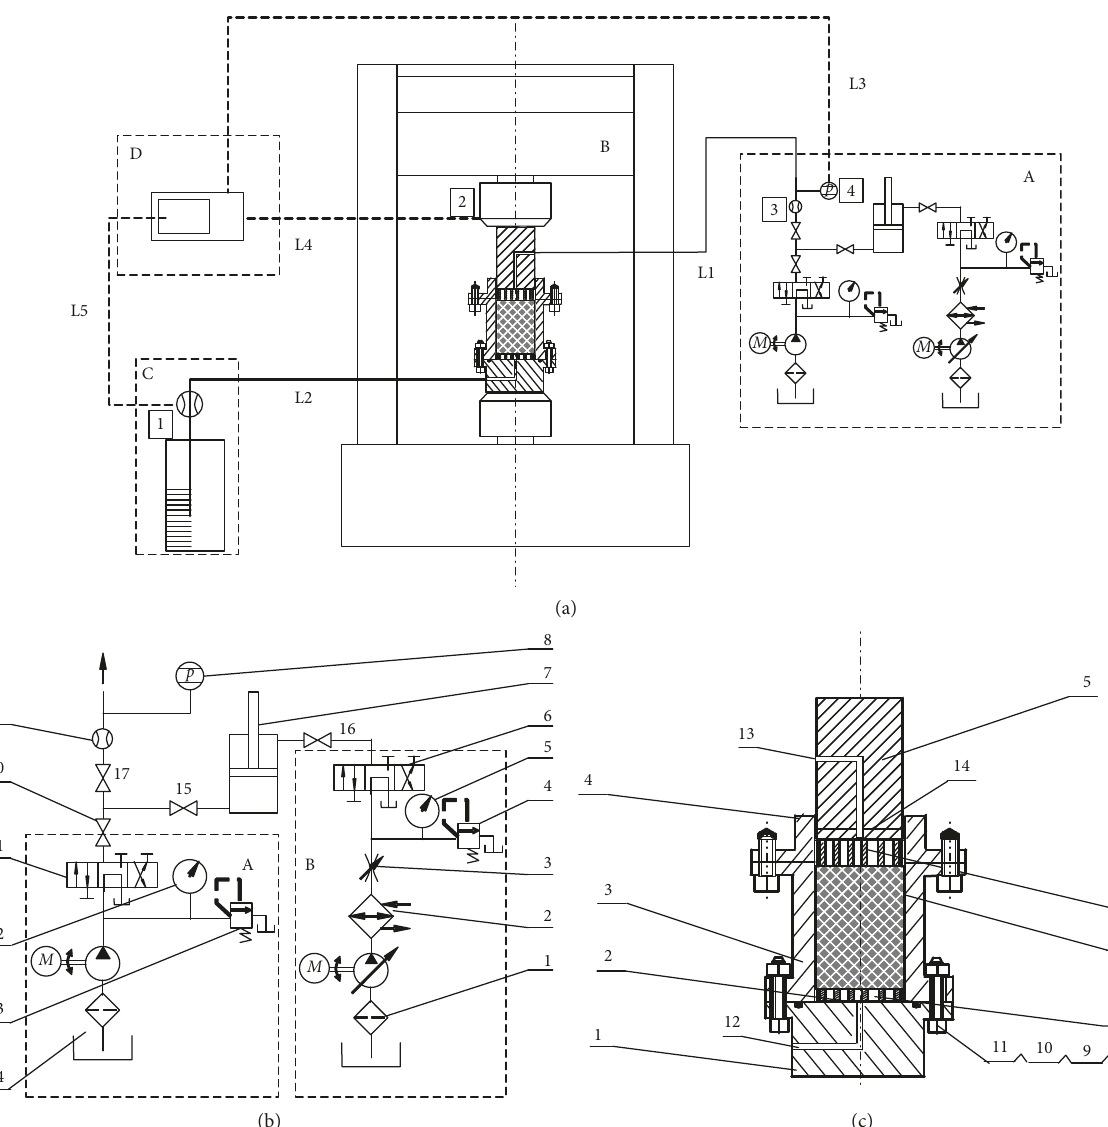
Figure 3: Seepage experimental system of fractured rock mass. (a) The whole composition of the system. A: seepage pressure supply system; B: axial pressure supply system; C: seepage system; D: data collection system; E: permeable mixture collection system. (b) Supply system of seepage pressure.1: variable displacement piston pump; 2: cooler; 3: throttle; 4, 13: spill valve; 5, 12: pressure gage; 6, 11: reversing valve; 7: